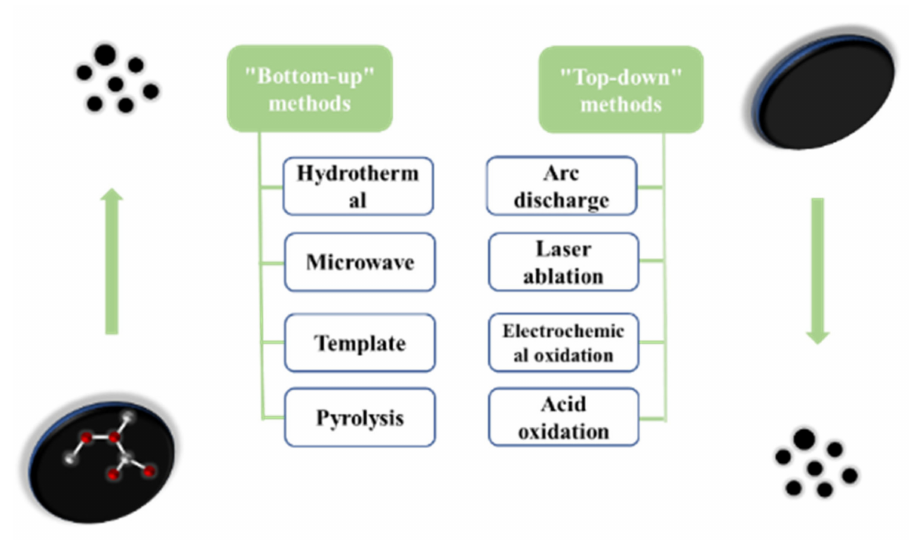
Figure 2. The two preparation methods of carbon